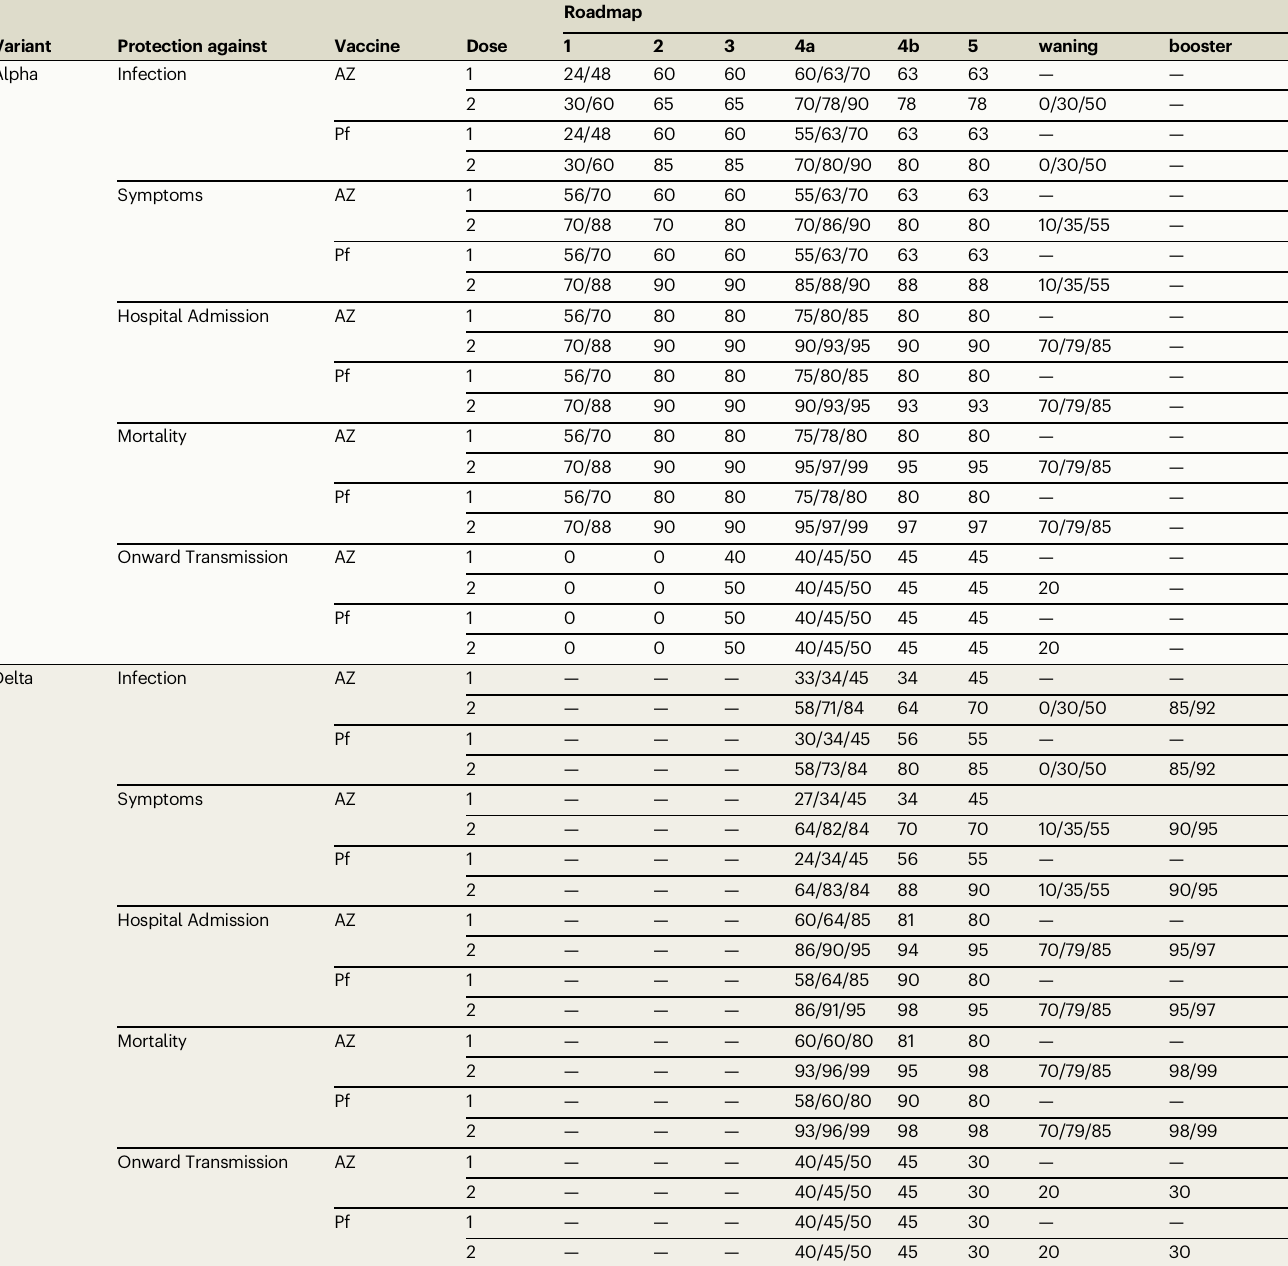
Table 1 | Assumed percentage protection from vaccination against Alpha and Delta variants from the six Roadmap documents